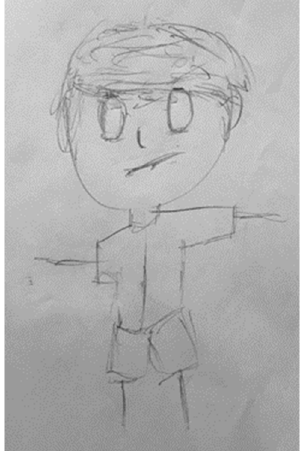
Figure 5. The drawing of a 15-year-old male participant who reported experiencing CEA. The drawing indicators found in the drawing included the hollow eyes, the omission of arms and hands, and the emphasized hair indicators.